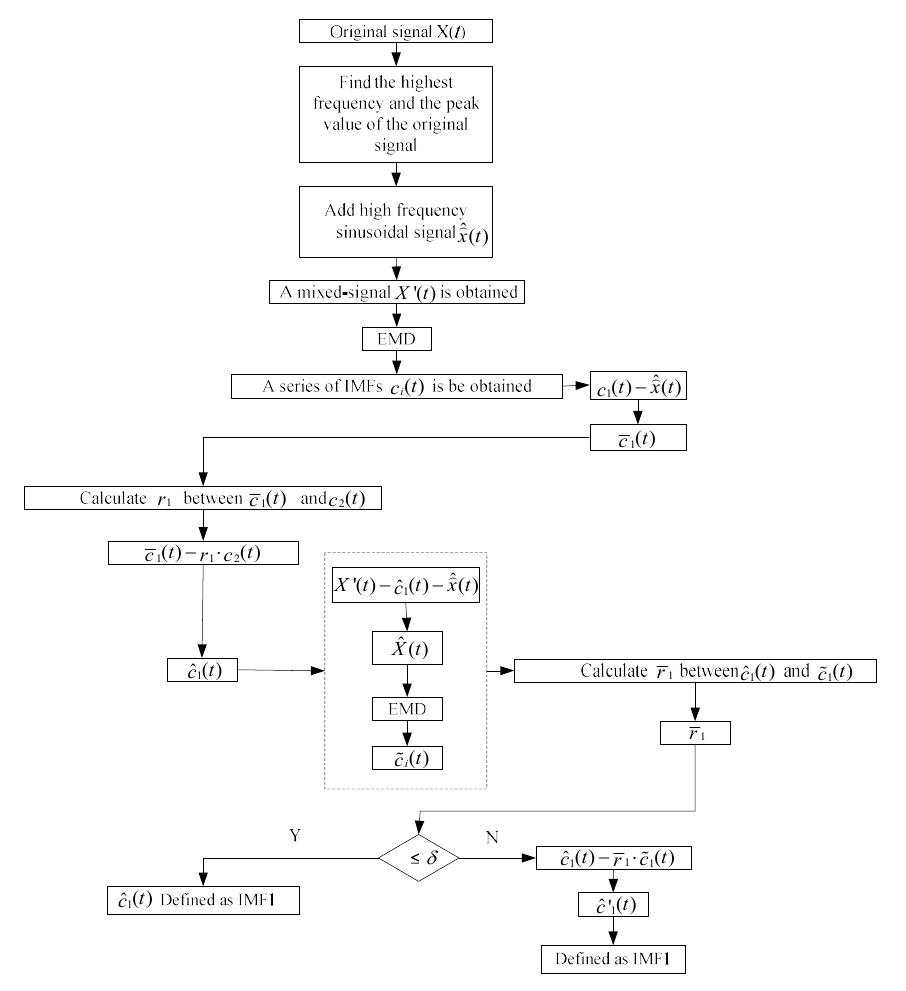
Figure 17. The flow chart for eliminating mode mixing.